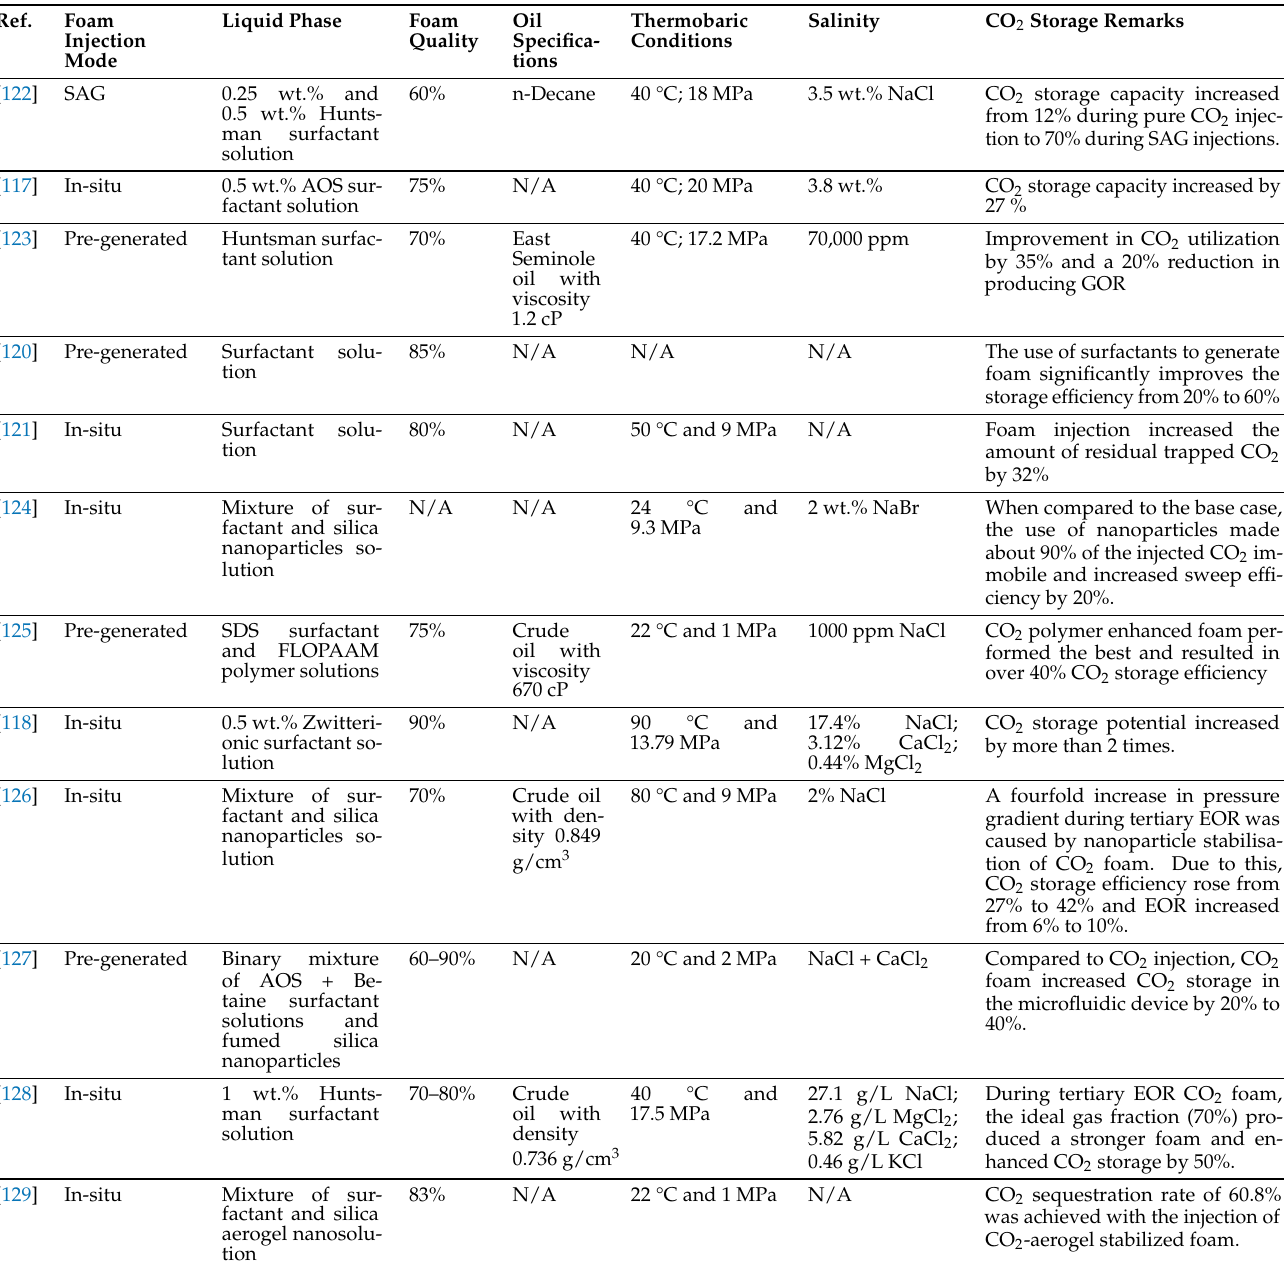
Table 1. Studies on the use of foam for CO 2